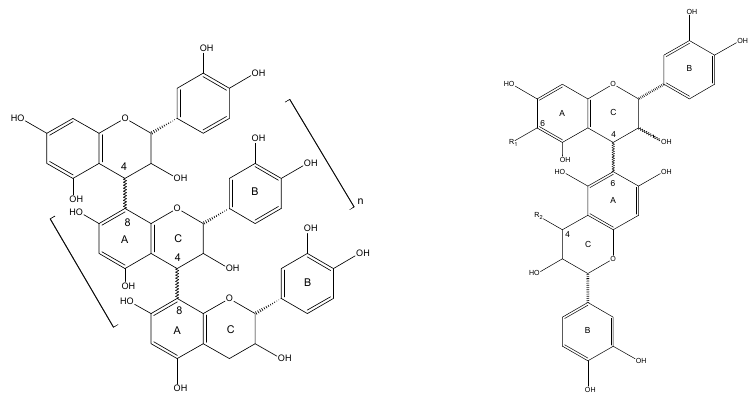
Figure 1. Polymeric procyanidin units containing C 4 -C 8 bonds ( left ) and C 4 -C 6 bonds ( right ).